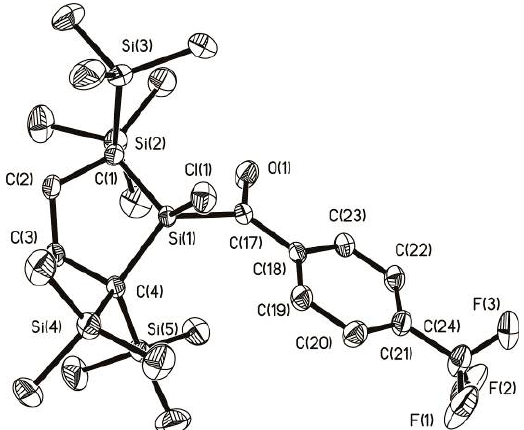
Figure 3. ORTEP drawing of compound 3c . (Hydrogen atoms are omitted for clarity. Thermal ellipsoids are shown at the 30% probability level.) Selected bond lengths (Å) and angles (°): Si(1)–C(1)